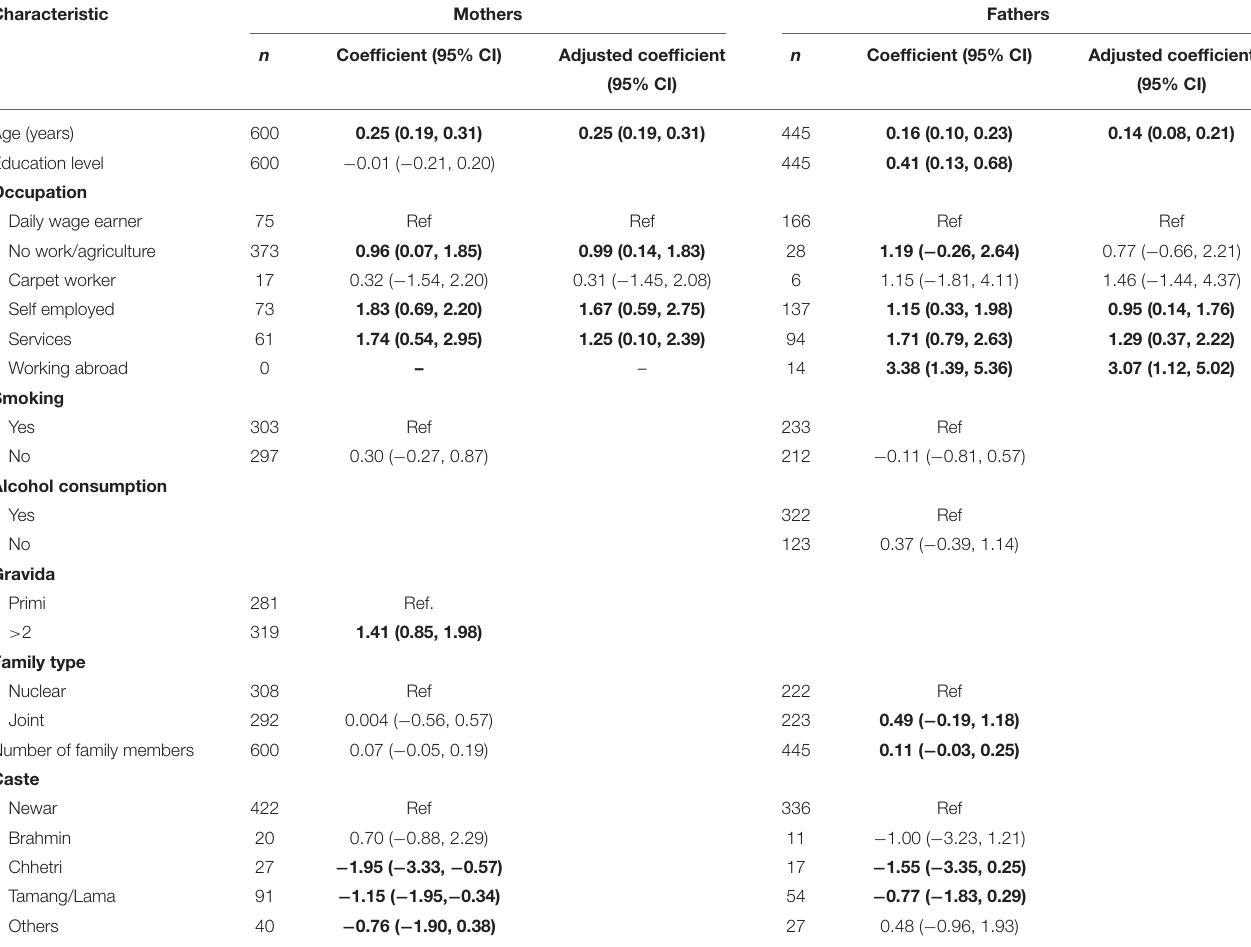
TABLE 2 | Association between body mass index (BMI in kg/m 2 ) of mothers and fathers and selected baseline characteristics, estimated in linear regression models.